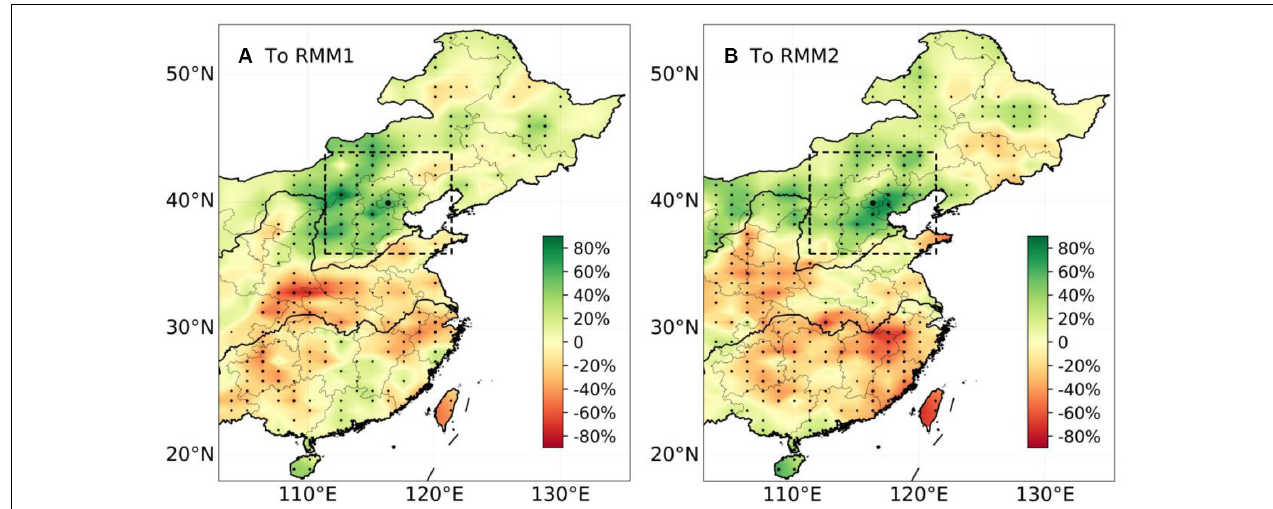
FIGURE 5 | The regressed pattern of the summer precipitation anomaly onto (A) RMM1 and (B) RMM2 in 2018 (the dotted areas exceed 95% confidence level). Unit: %.